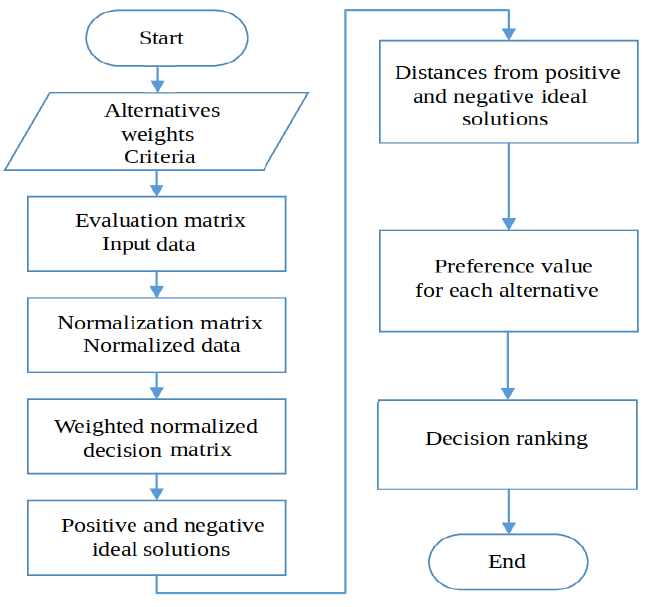
Fig. 1. Flowchart of the unmodified TOPSIS.